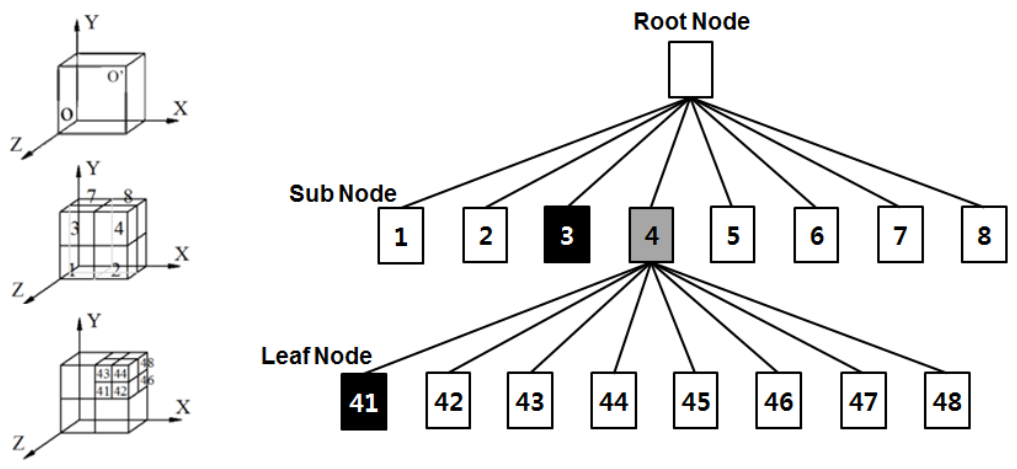
Figure 2. The depth first (DF)-representation of the octree data structure.